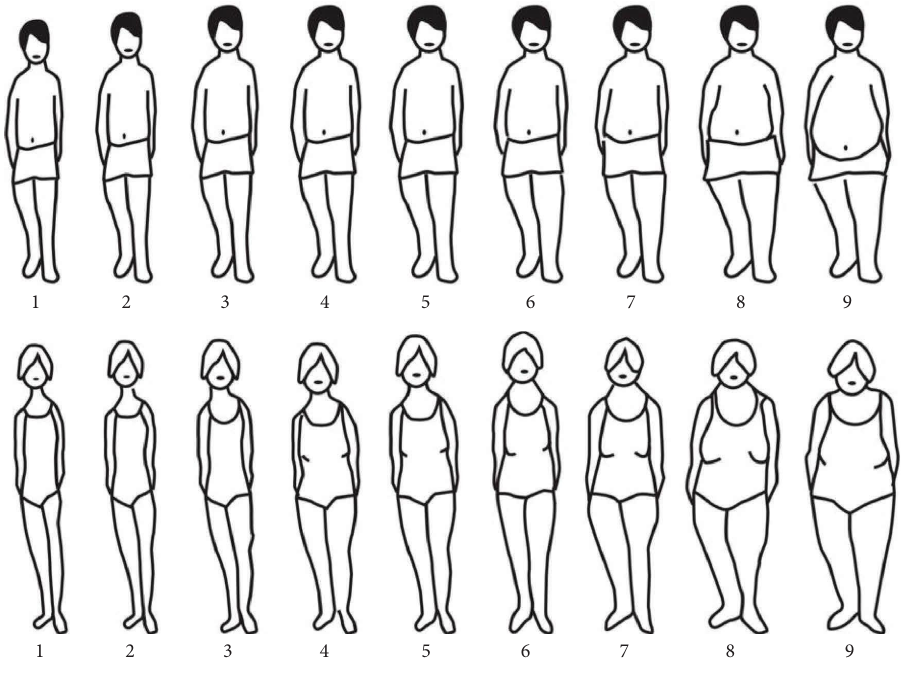
Figure 1: Male and female drawings of the body